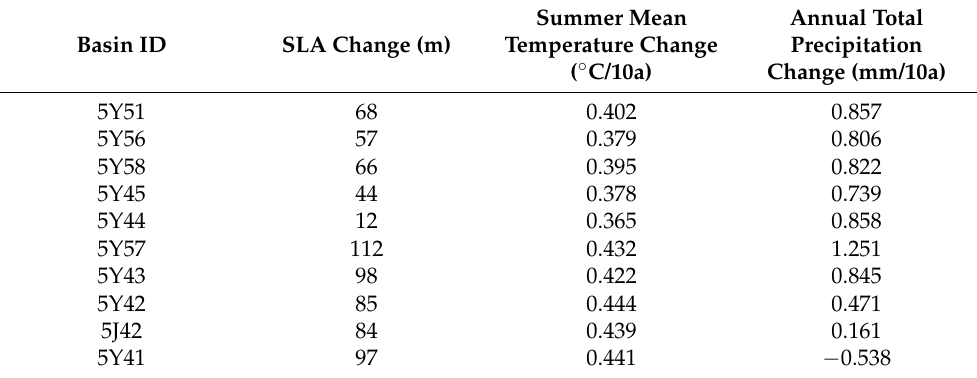
Table 7. SLA, summer average precipitation and annual total precipitation change in each basin of Qilian Mountains from 1989 to